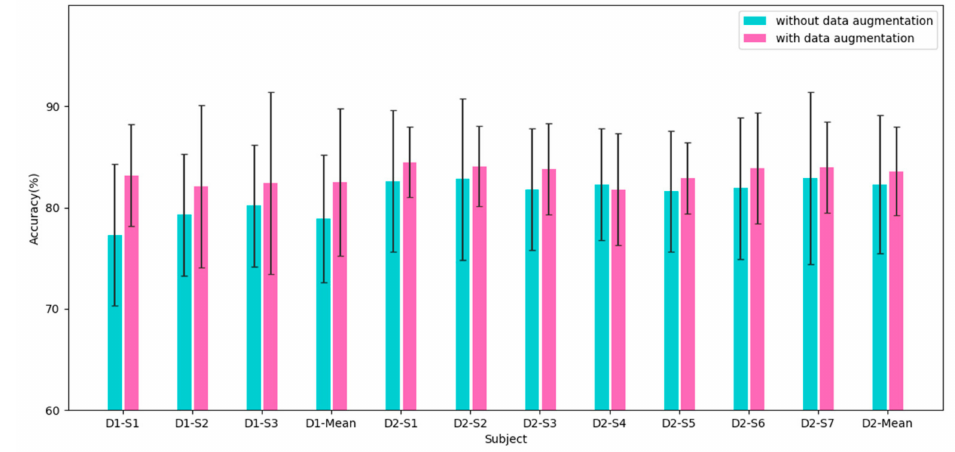
Figure 6. The average of the real and the generated samples from different subjects.